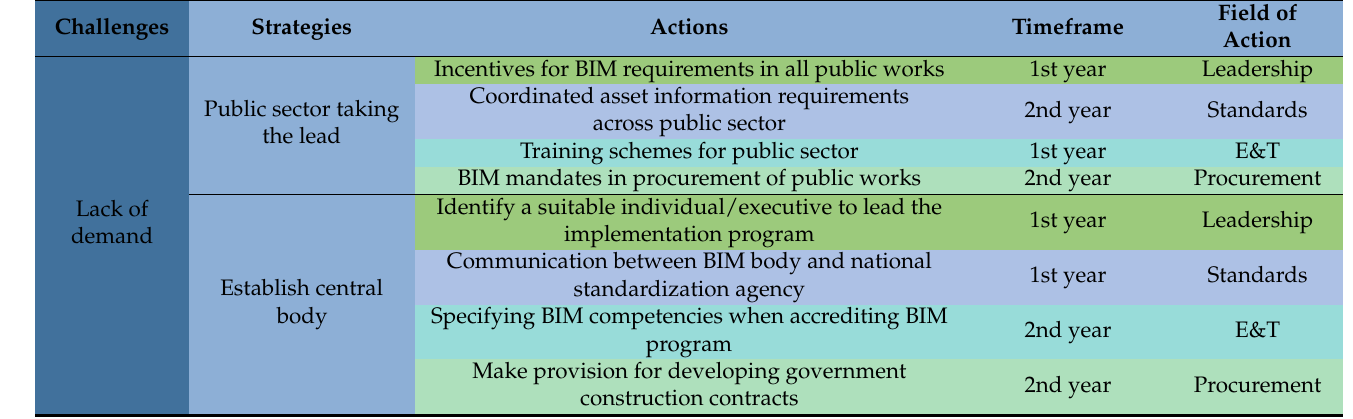
Table A1. The summary of the proposed National Roadmap for introduction of